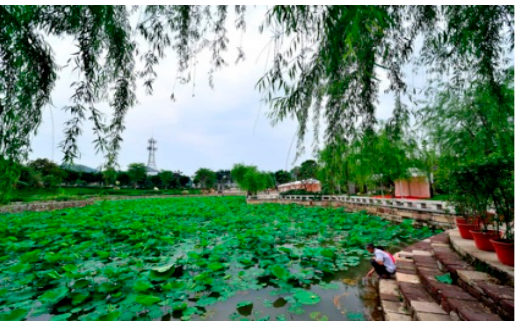
Figure 10. West Square. (Source: the authors.).